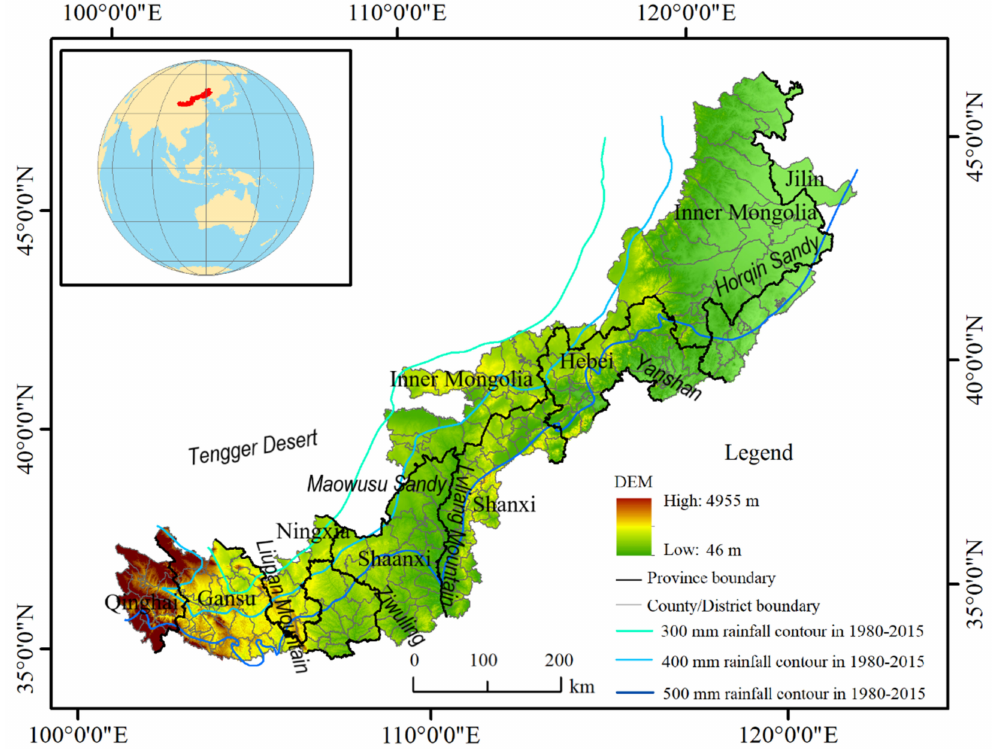
Figure 1. Location and topography of the study